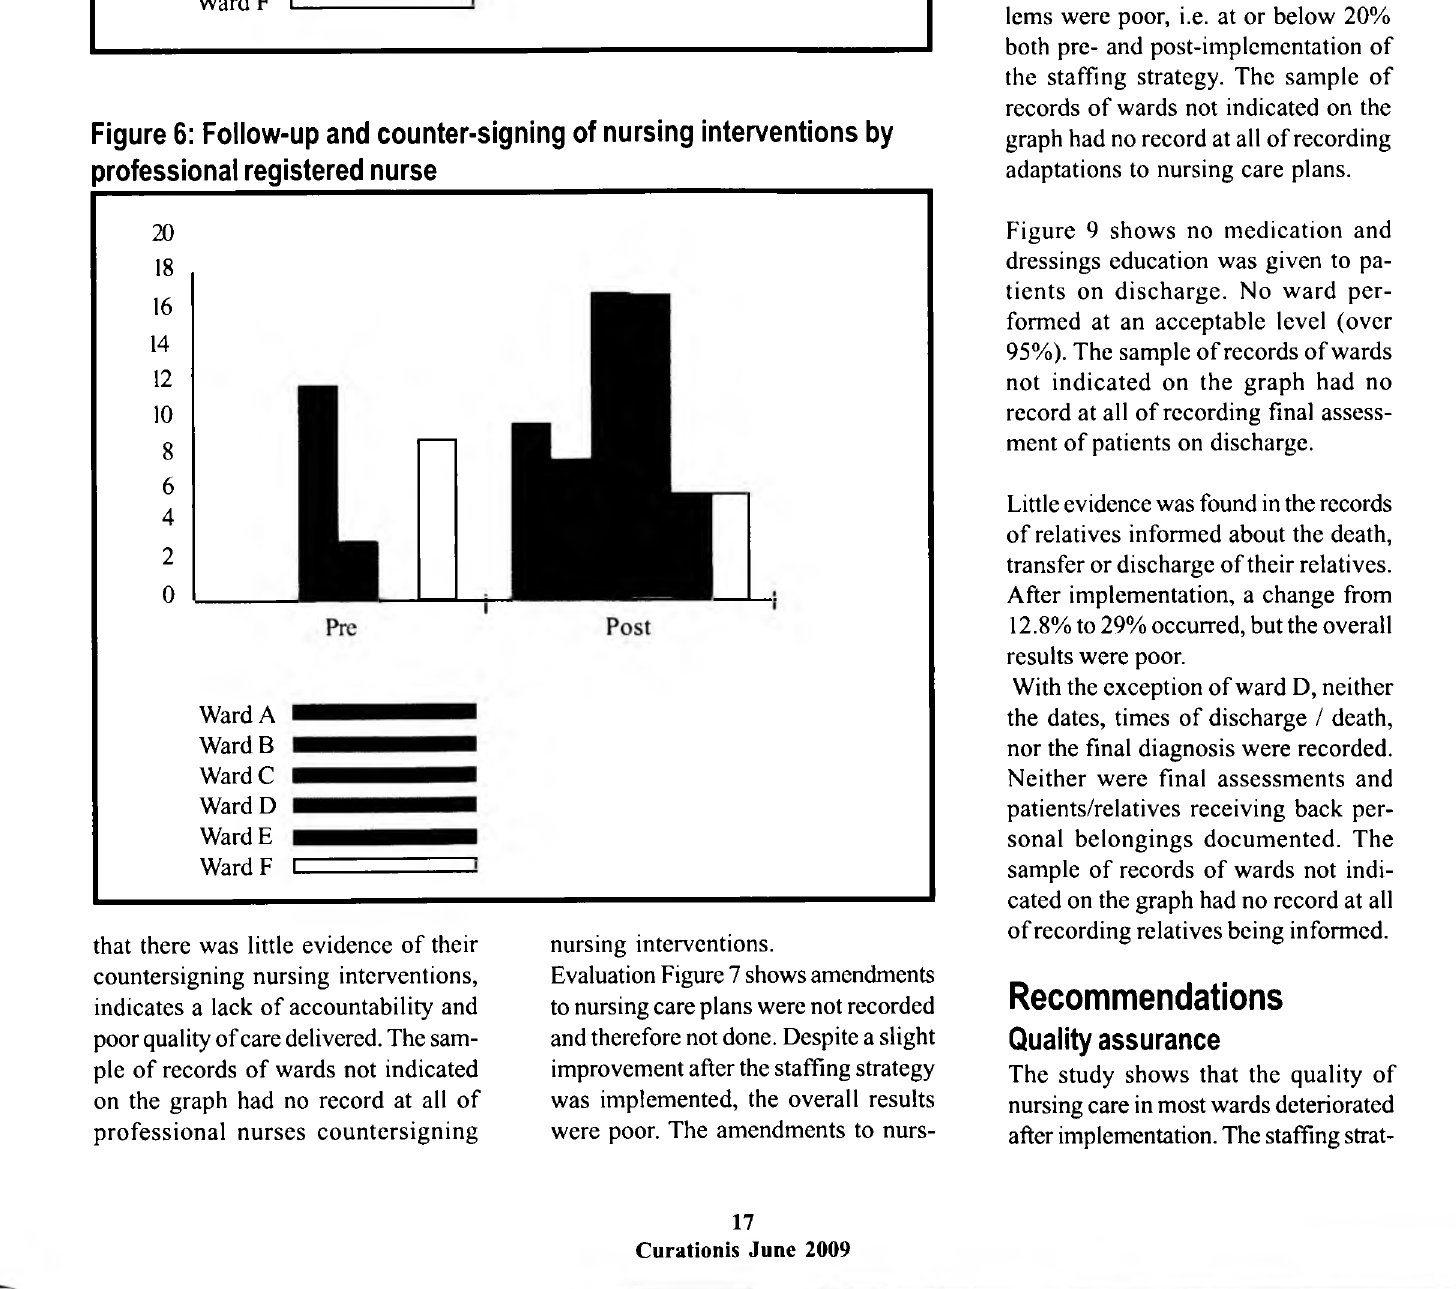
Figure 6: Follow-up and counter-signing of nursing interventions